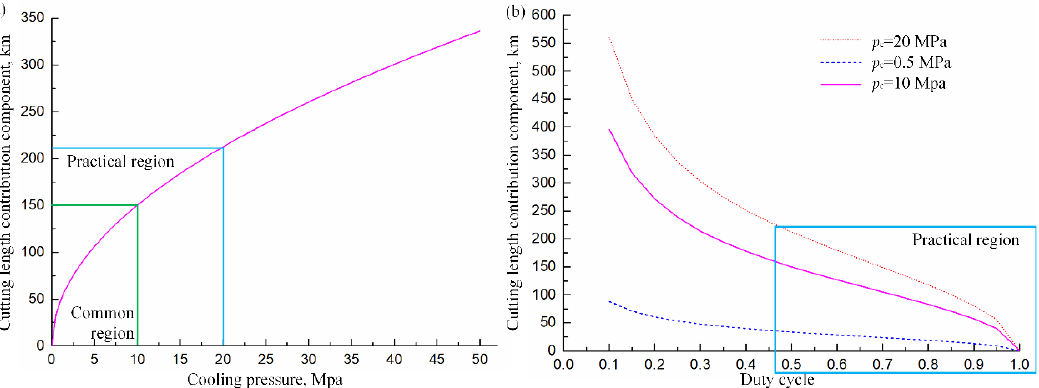
Figure 8. Tool life contribution components of HUVC of Ti alloys, ( a ) effects of cooling pressure, duty cycle is 0.5 and ( b ) effects of duty cycle. Feed per revolution and cutting depth are 0.005 mm/r and 0.05 mm, respectively. p c , cooling pressure.